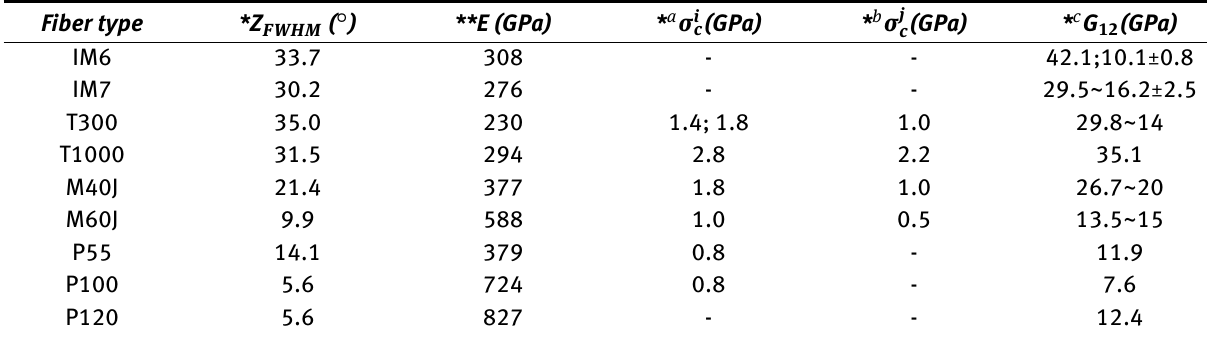
Table 3: Carbon fiber basic properties and comparison of carbon fiber, glass fiber and Kevlar fiber and carbon steel [39] Fiber